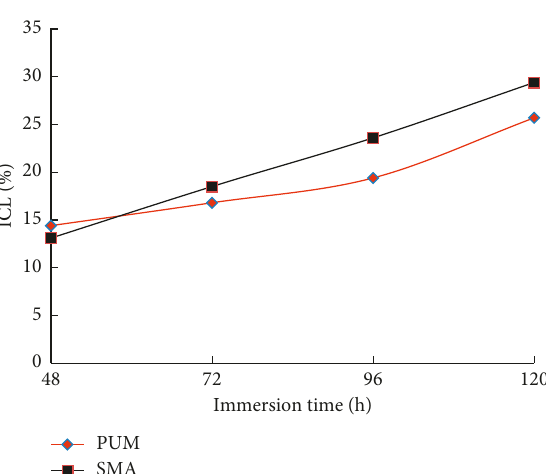
Figure 18: Immersion Cantabro loss (ICL) results.